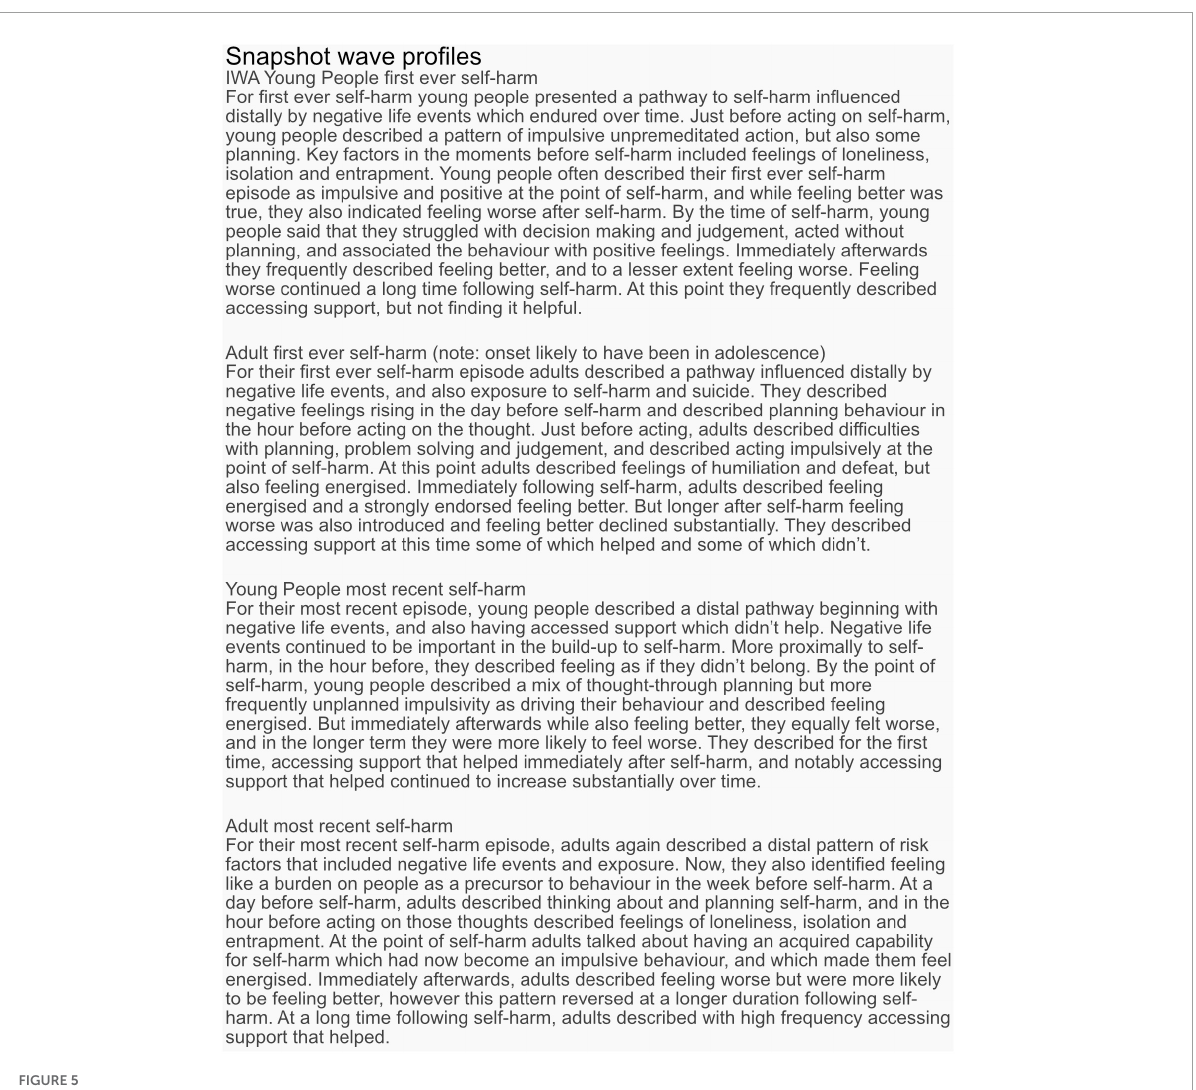
FIGURE5 Snapshot wave profiles based on notable category selection by time